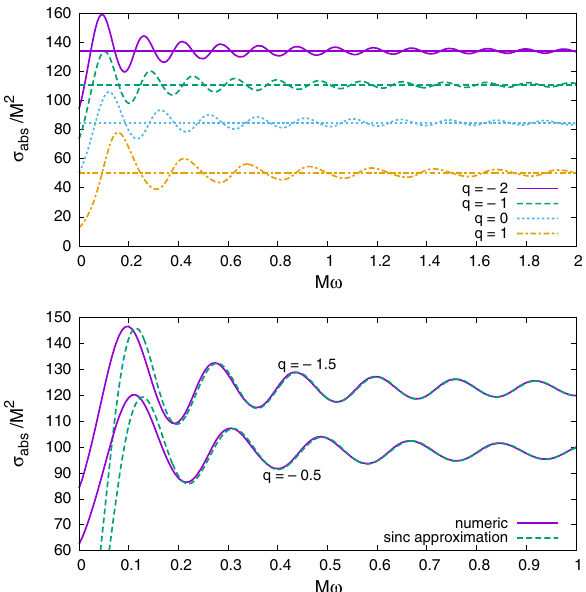
Fig. 5 Total scalar absorption cross section of black holes with tidal charges q = − 2 , − 1, Schwarzschild ( q = 0) and extreme Reissner– Nordström ( q = 1) black holes compared with the geometrical-optics limit (top) and for q = − 0 . 5 , − 1 . 5 compared with the “sinc approxi- mation” [32] (bottom)